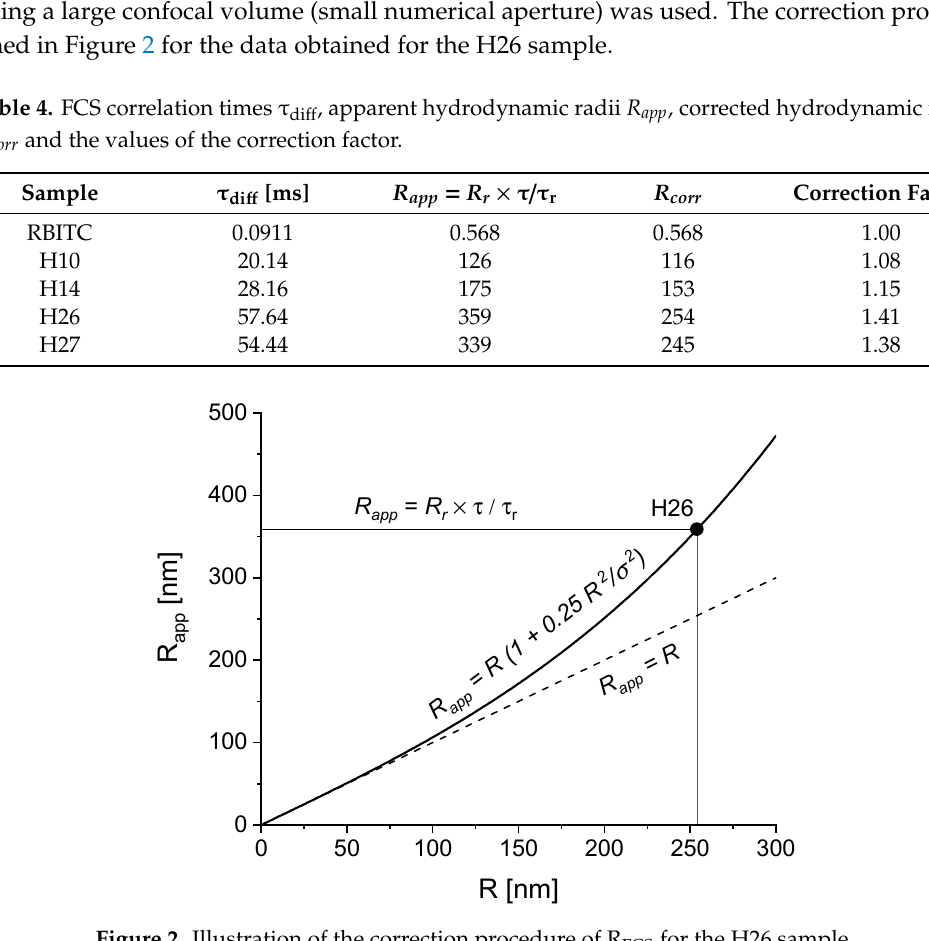
were spherical in shape. Visible in Figure 3D, a large divergence of particle size illustrates the relatively high polydispersity of the H27 sample. Note that SEM was applied only in the studies of whole particle morphology. The fluorescent cores alone were imaged using a TEM